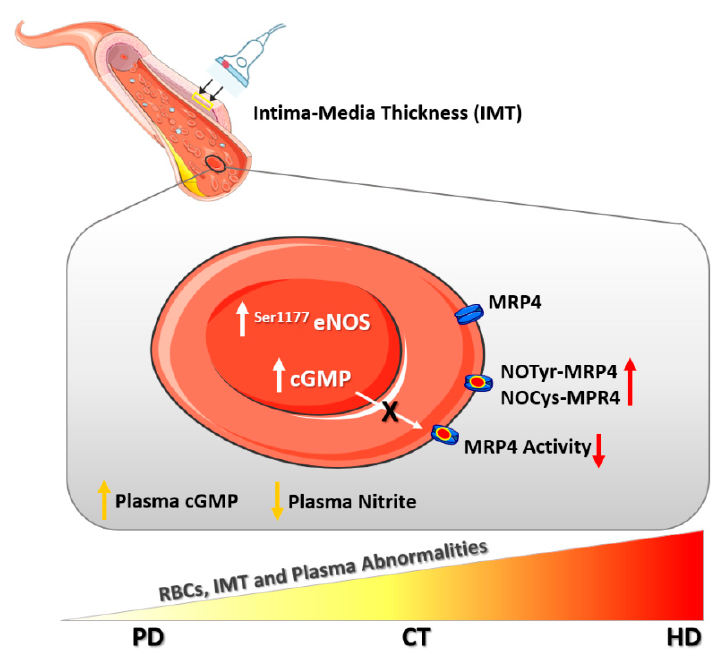
Figure 8. Red blood cell (RBC) and plasma abnormalities in Chronic Kidney Disease (CKD) progression. Uremic RBC showed a compensatory increase of eNOS (endothelial Nitric Oxide Synthase, also named RBC-NOS) phosphorylation levels along with intra-erythrocyte accumulation of cGMP (cyclic Guanosine Monophosphate). The latter mainly caused by decreased ATPase activity of MRP4 (multidrug-resistance-associated protein-4), a known cGMP membrane transporter, caused by rising levels of tyrosine nitration and cysteine nitrosylation of this transporter (NOTyr-MRP4 and NOCys-MRP4). Moreover, plasma levels of cGMP increased, potentially as a consequence of reduced renal clearance, while plasma Nitrite levels decreased. Notably, Peritoneal Dialysis (PD) impaired these parameters to a lesser extent than other CKD therapies. In parallel, the carotid Intima-Media Thickness (IMT), which was measured on the right and left common carotids, significantly increased in patients on Conservative Therapies (CT) and Hemodialysis (HD), while in patients on PD was comparable to healthy subjects.